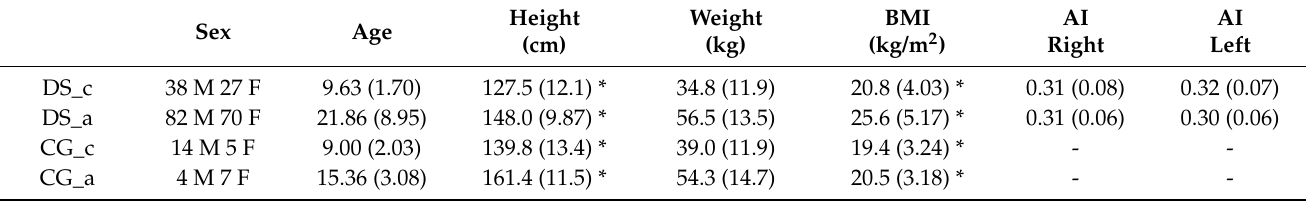
Table 1. Mean and (standard deviation) values of anthropometric data of the control and DS groups divided into children and young adults. M, males; F, females; BMI, body mass index; AI right, arch index of the right foot; AI left, arch index of the left foot; * p -value < 0.05 when comparing the control and DS